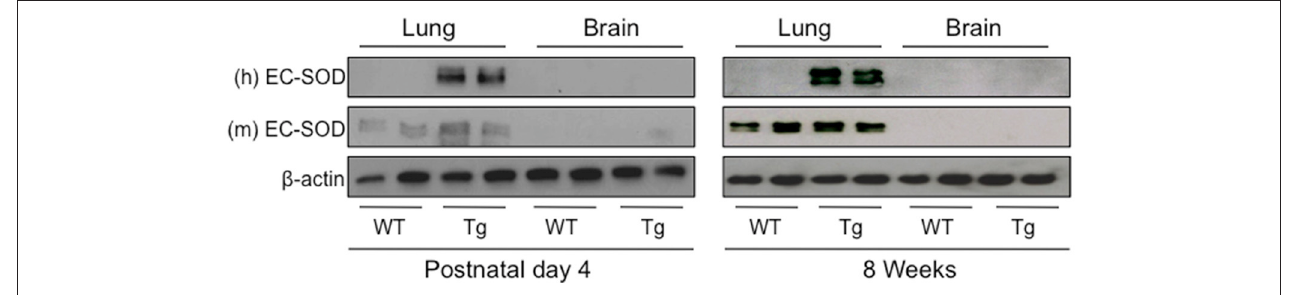
FIGURE 1 | Human EC-SOD protein is detected in the lungs, but not brains, of transgenic Sftpc EC − SOD mice. Lung and brain tissues were harvested on postnatal day 4 and at 8 weeks of age from wild type (WT) and Sftpc EC − SOD transgenic (Tg) mice birthed into room air. Lung and brain homogenates were immunoblotted with antibodies to detect human (h) EC-SOD, mouse (m) EC-SOD, and β -actin (loading control). Each lane represents an individual mouse.